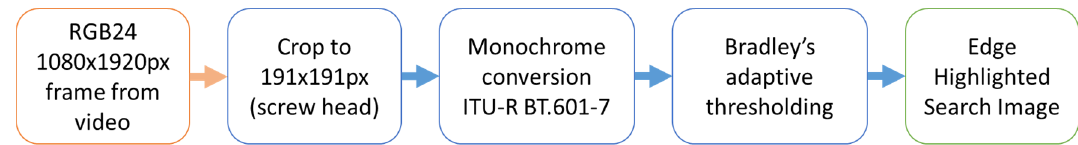
Figure 4. ( a ) Original grayscale: Grayscale conversion of the first frame of the video (Figure 3a) using luminance [50]; ( b ) Otsu threshold: Comparison of Otsu’s thresholding [51]; ( c ) Adaptive thresholding (Bradley) [52,53] with sensitivity: 0,99; ( d ) Not-Sobel filtering [54,55] applied to the grayscale image in (a).